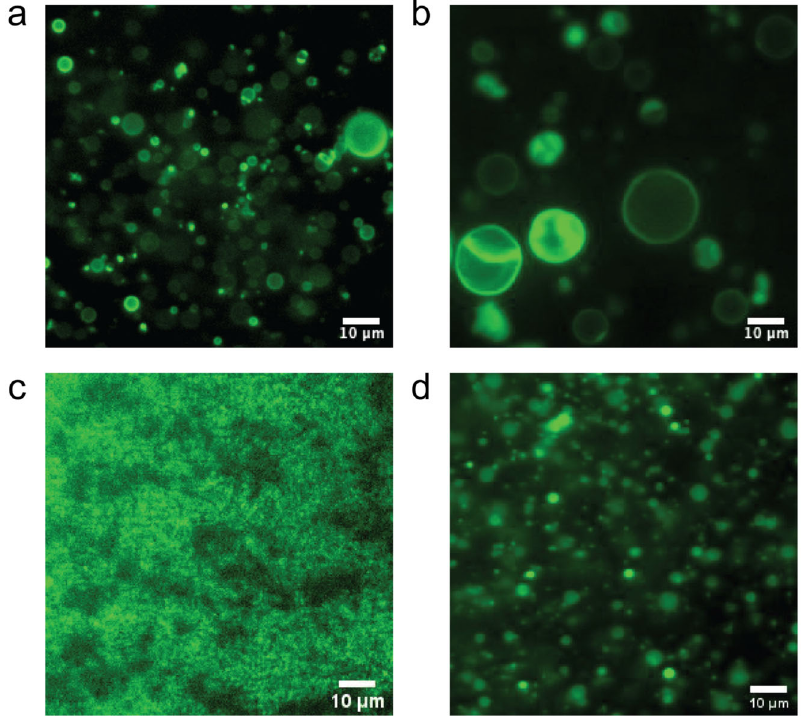
Fig. 4 Fluorescent images for monomer effects on Phoenix dynamics. Phoenix dynamics of oxygen-rich PISA specimens when exposed to blue light irradiation from microscope: a HPMA, b HBA, c BA, d